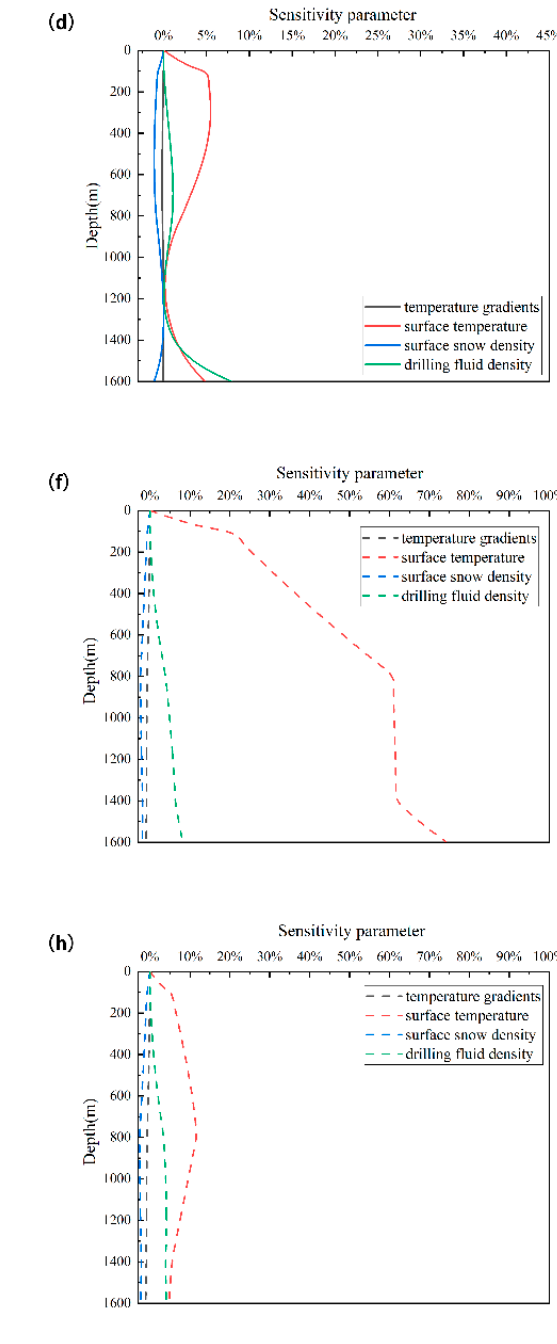
Figure 11. Sensitivity results for borehole diameter. (( a – d ) show sensitivity when the sensitivity factor is floated by − 100%, − 50%, 50%, and 100%, respectively, in the σ h direction. while ( e – h ) show the sensitivity results in the σ H direction).